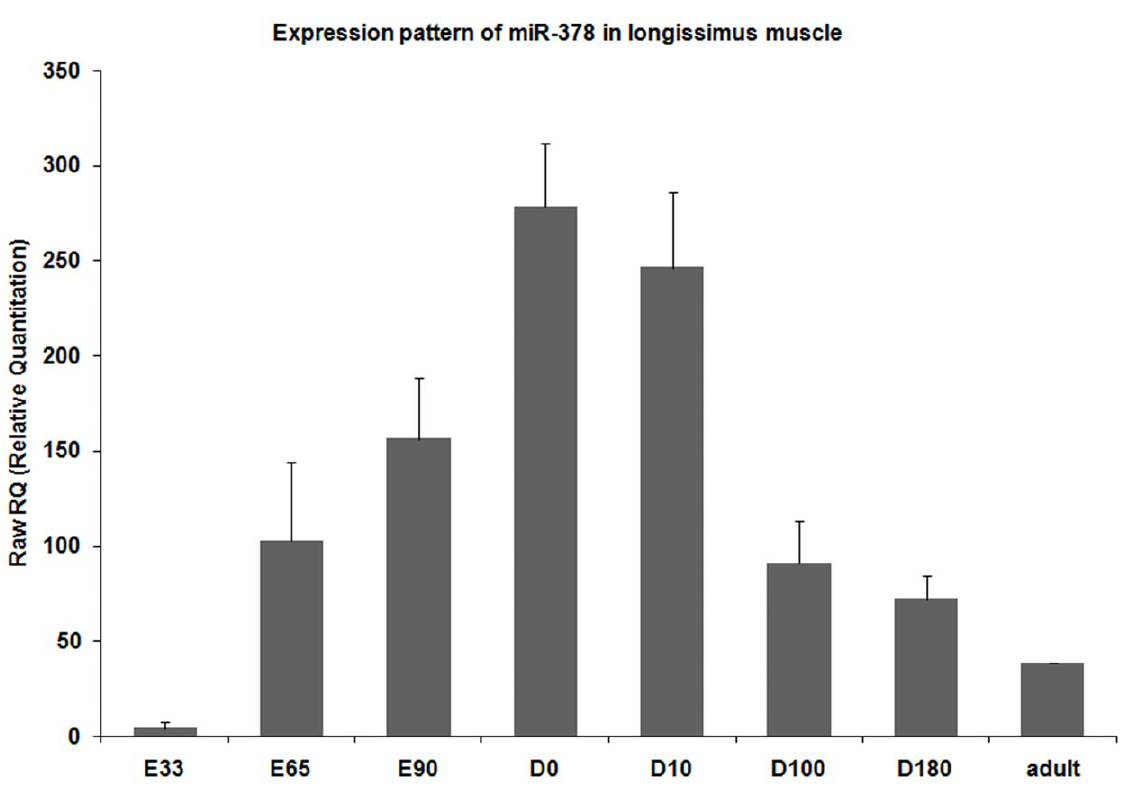
Figure 3. Expression profiles of miR-378 during various development periods. Total RNAs was isolated from porcine longissimus muscle during different dpc (E) and postnatal days (D), and qPCR was performed using stem-loop RT-PCR. The expression levels were analyzed using the DD Ct method and normalized against U6. Each sample was run in triplicate, and the calculation standard deviation was shown.